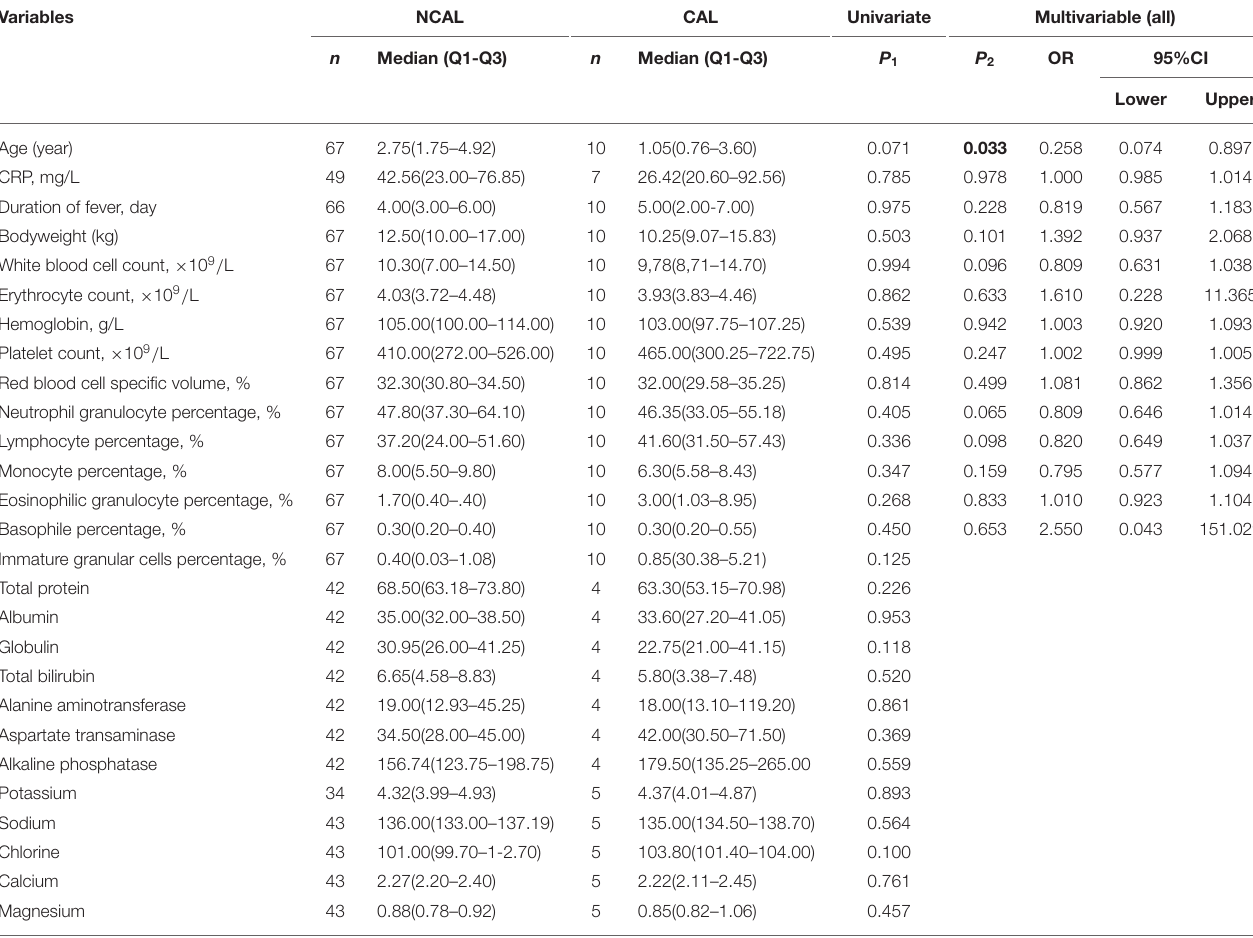
TABLE 3 | Comparison of groups with coronary artery lesions and no-coronary artery lesions with using anibiotics.